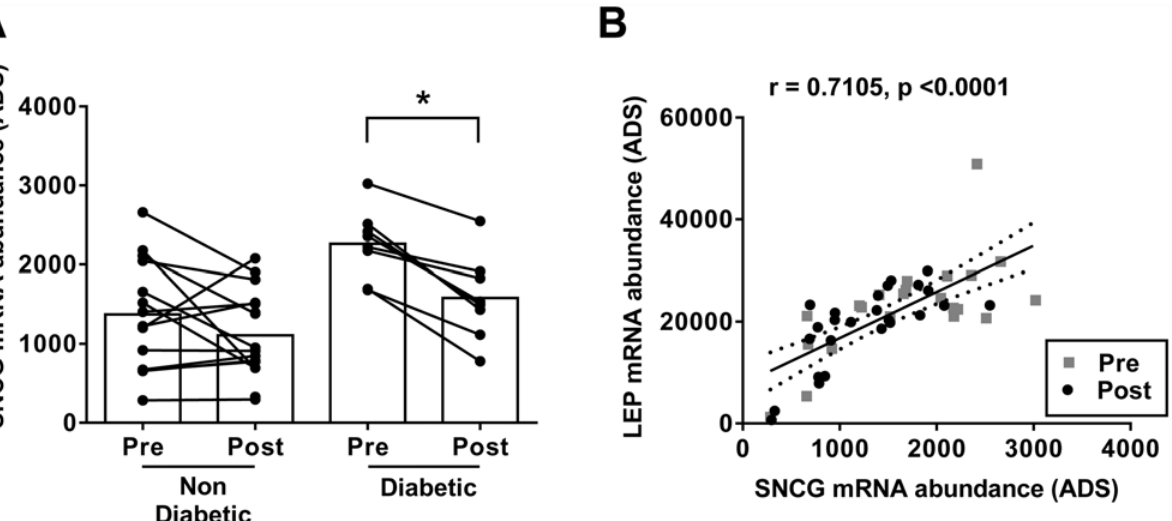
Fig 3. COHORT 1: 12 weeks PIO treatment significantly decreased synuclein- γ (SNCG) mRNA expression in subcutaneous white adipose tissue (SC-WAT) from pre-treatment levels in subjects with type 2 diabetes (n = 8) but not in non-diabetics (n = 17). (A) . * P < 0.05, paired t test. Pre- and post- treatment SC-WAT expression levels of SNCG and LEP in the same subjects were highly-correlated in T2DM and non-diabetic subjects, using Pearson ’ s correlation statistic (B) . ADS — average difference score calculated using Affymetrix MAS5.0. Raw data is provided in S1 Data.